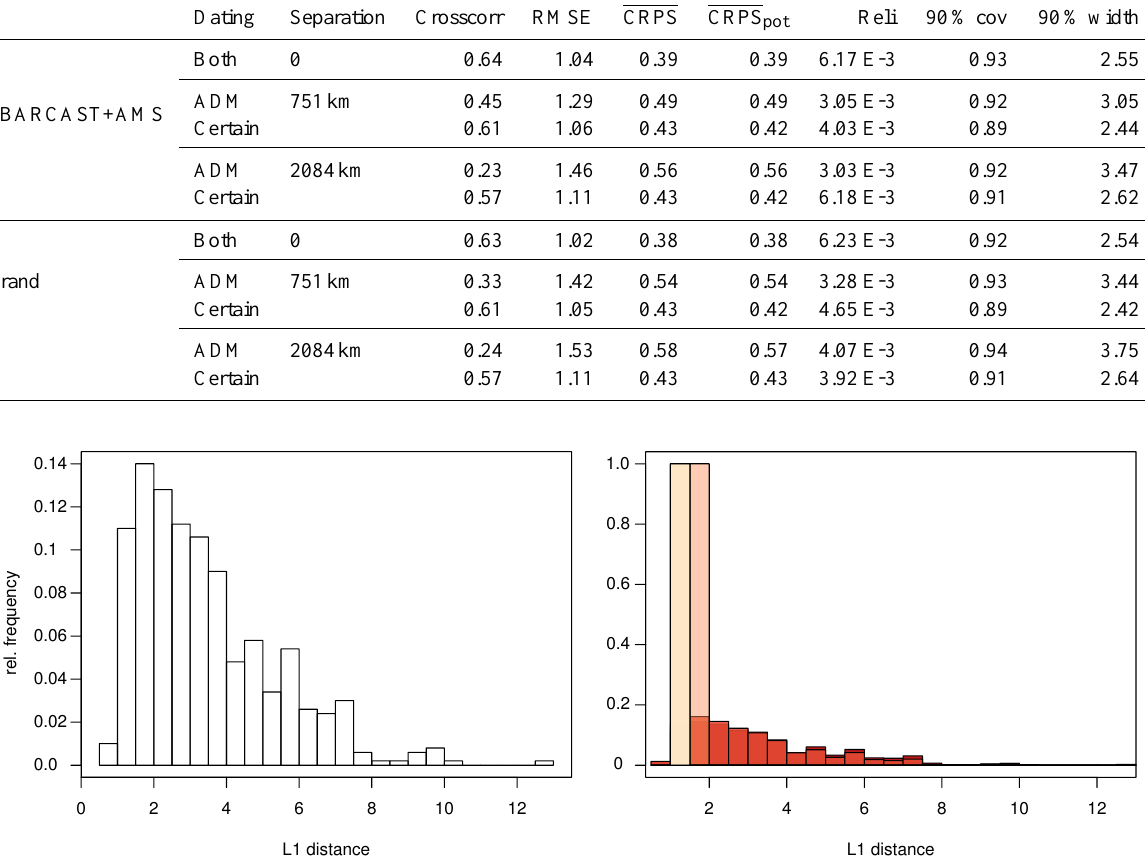
Table 2. Experimental results with one time-certain and one time-uncertain proxy record, with instrumental data present, for both BAR- CAST+AMS and random ADM selection (rand). Results are shown at the location of the time-certain proxy (“Certain”) and the location of the time-uncertain proxy (“ADM”). The spatial decorrelation length scale is 2000km, and the separation between the proxies varies between experiments. The reconstructions are evaluated over the pre-instrumental period only. The standard deviation of the local target climate signal is about 1.3.